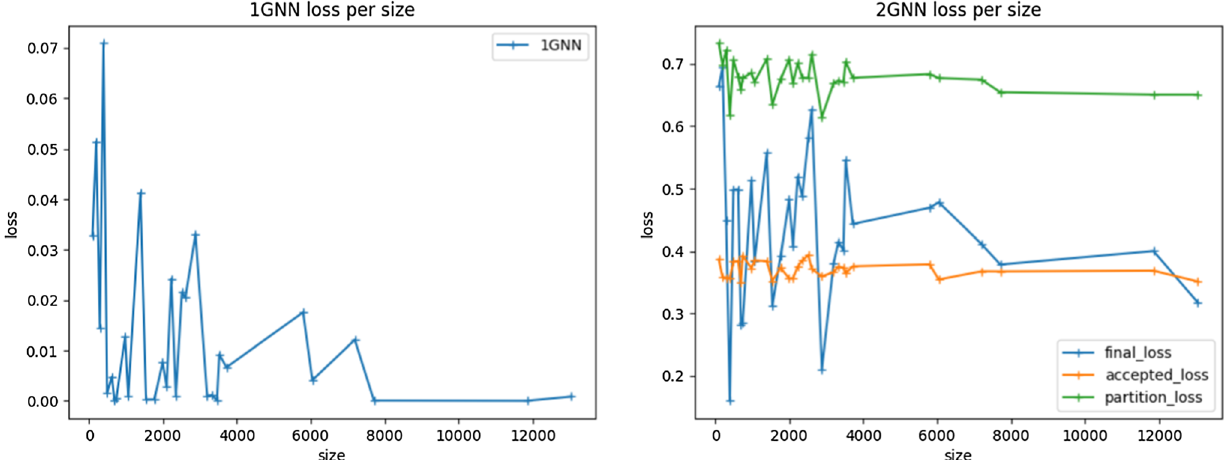
Fig. 6 MSE loss of the 1GNN model (left) and logloss of the two GNNs of the 2GNN model together with the MSE loss (final_loss) of the polarization computed with the 2GNN model (right). The accepted loss is the logloss of the first GIN used to compute the set of